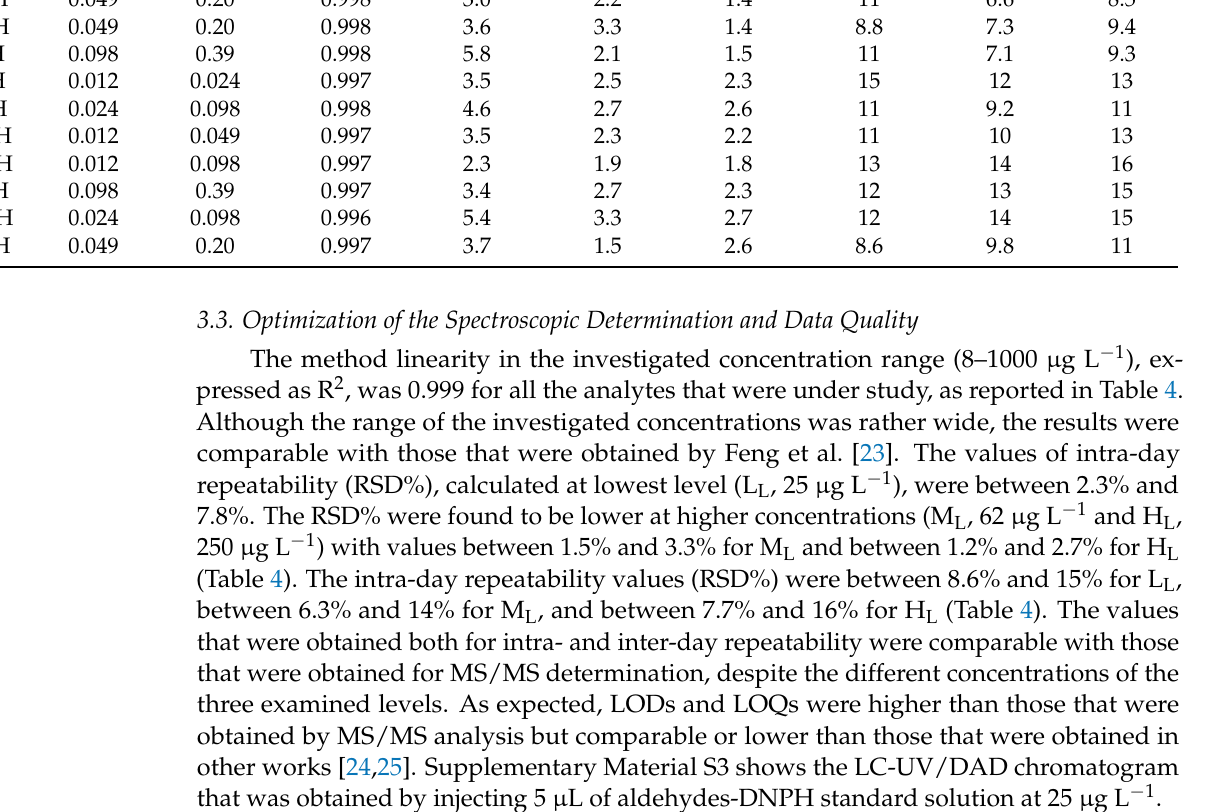
Table 4. LODs ( µ g L − 1 ), LOQs ( µ g L − 1 ), linearity (R 2 ), and the intra- and inter-day repeatability (RSD%) that were obtained from the LC-UV/DAD optimized method. L L , M L , and H L